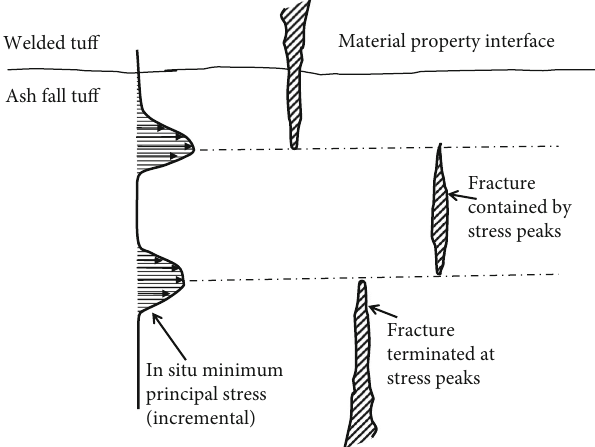
Figure 2: The minimum horizontal stress pro fi le and hydraulic fracture growth and termination plotted based on hydraulic fracture mined-back measurements ([10] with modi fi cation).